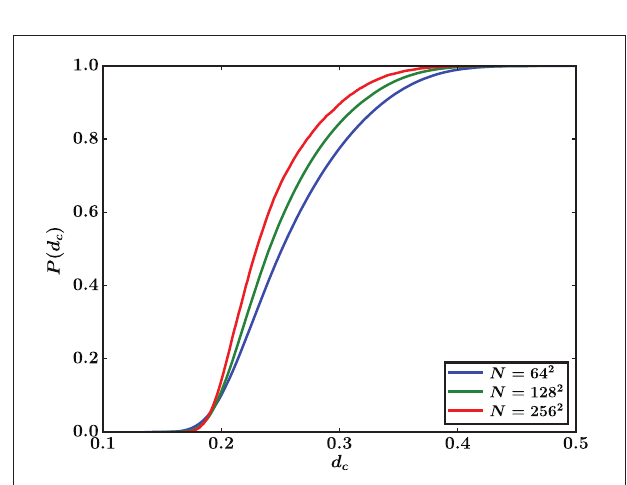
FIGURE 9 | Cumulative distribution of critical damage P ( d c ) for LLS on a square lattice. The number of samples is 10 6 , 1.5 × 10 5 , and 1.5 × 10 4 for system sizes N = 64 2 , 128 2 , and 256 2 , respectively. The threshold distribution is P ( t ) = t 2